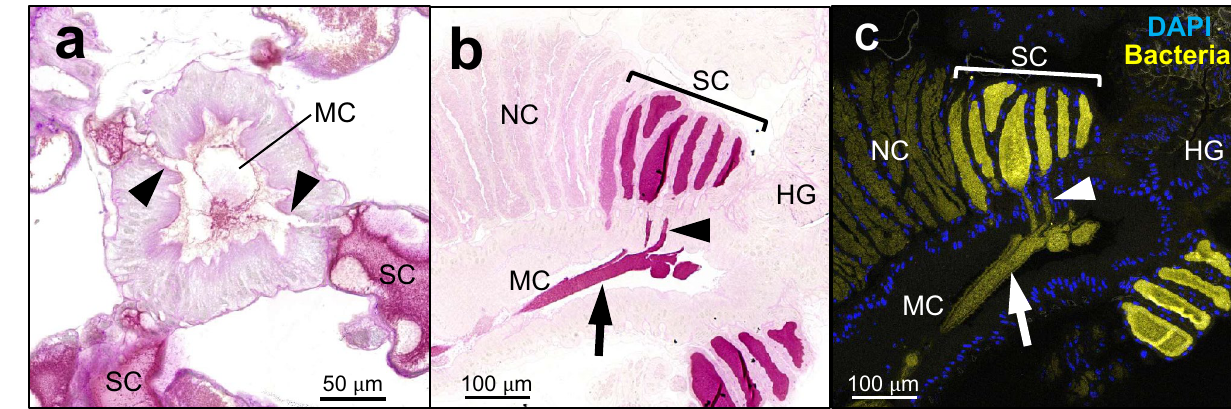
Figure 5. Co-localization of SC mucin protein and symbiotic bacteria in the swollen crypts, and their excretion to the midgut main cavity. ( a ) A cross section of the posterior midgut region of an adult female, on which the narrow ducts connecting the swollen crypts and the midgut main cavity are seen (arrowheads). ( b ) A longitudinal section of the posterior midgut region of an adult female, on which dense PAS signals are seen